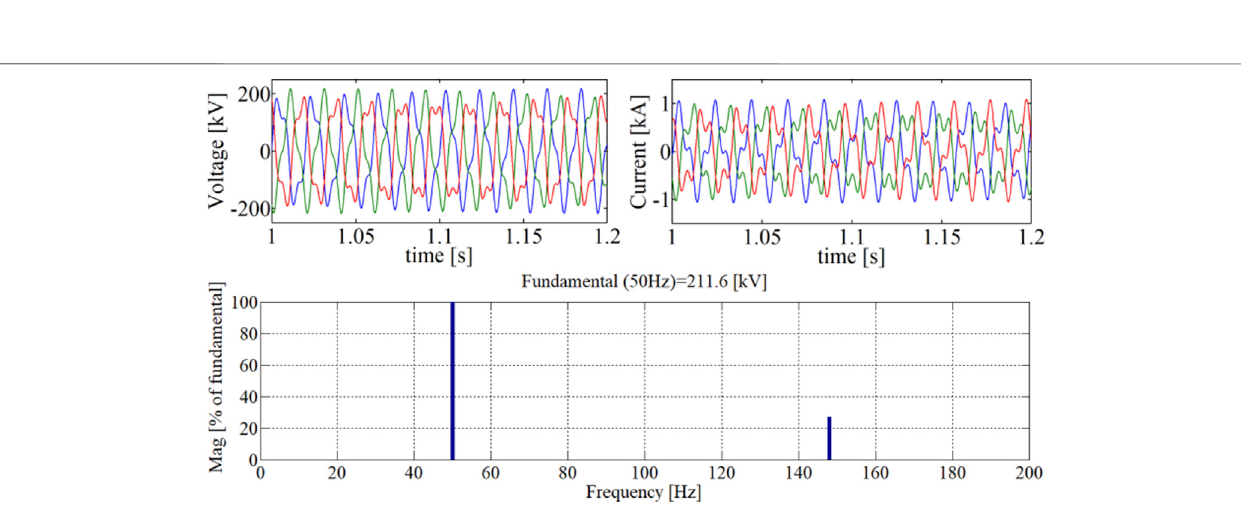
Frontiers in Energy Research |